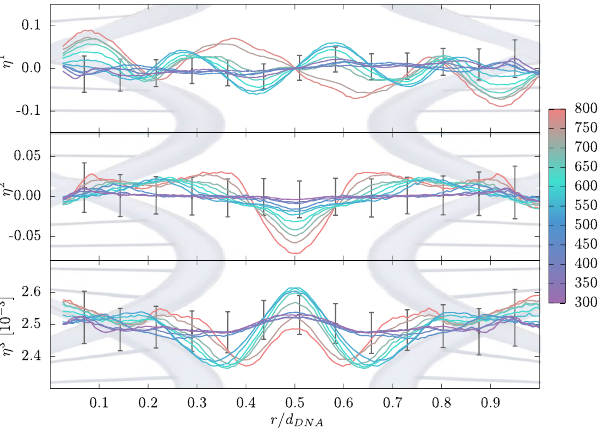
Figure 5. Order parameters η (1,2,3) between pairs of DNA molecules. For better comparison, the distances are scaled with DNA interaxial spacings, i.e., values r / d DNA = 0 and 1 correspond to COM of the first and second DNA molecule in the pair, respectively. The results are shown for DNA arrays with hex lattice and Na + counterions at various DNA concentrations indicated by the color palette. The error bars represent the standard deviation.